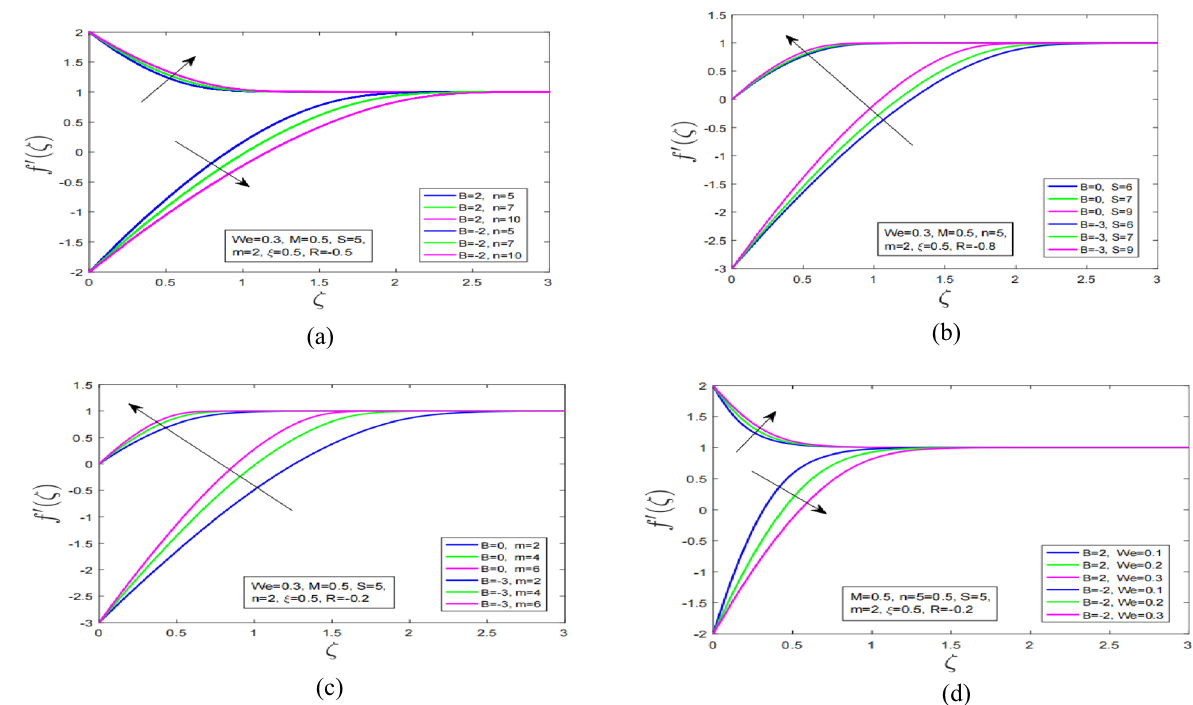
′ . ( b ) Suction impact on f ′